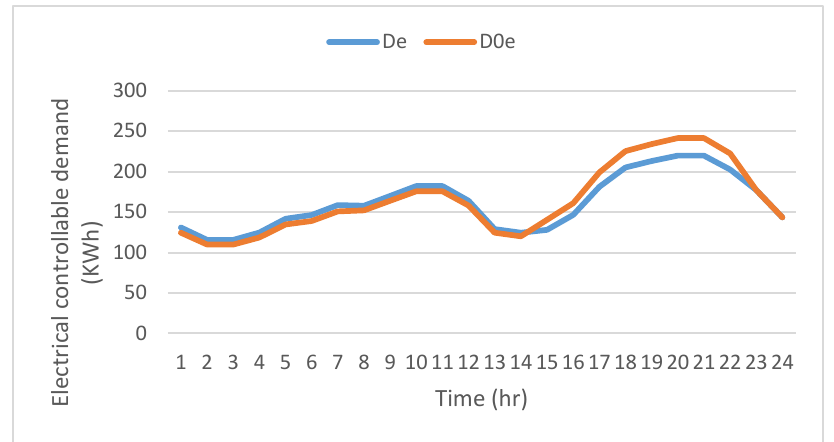
Figure 9. Design and Structure of proposed MCMG.